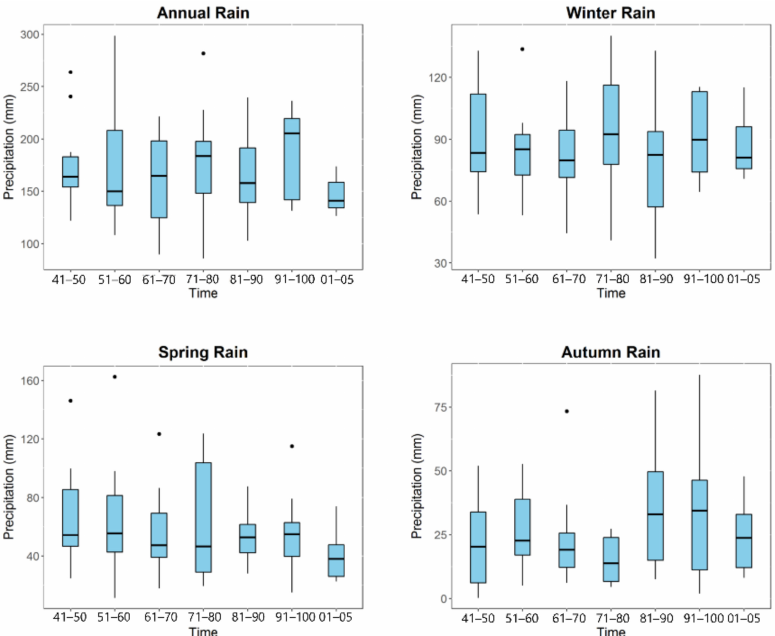
Figure 5. Box plots of average precipitation in Iraq for different temporal bands for